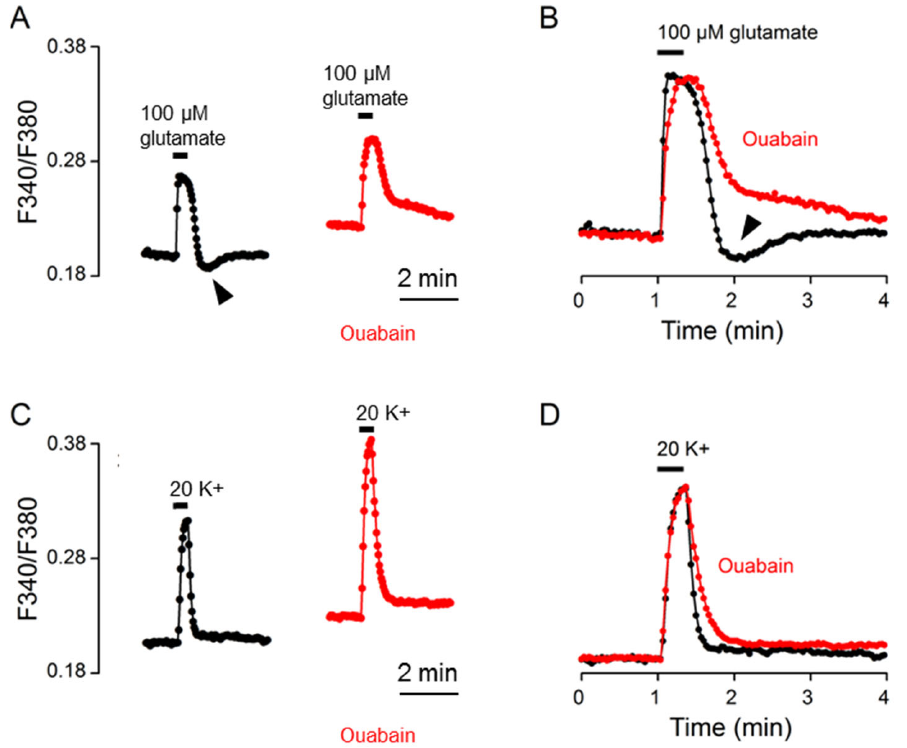
Figure 5. Ouabain effects on the Ca 2+ response to 100 µ M glutamate ( A , B ) and 20 mM K + ( C , D ) from the same cells. ( A , C ) A representative experiment (an average of 13 cells) showing the effects of 10 µ M ouabain on the Ca 2+ responses to 100 µ M glutamate ( A ) and 20 mM K + ( C ). ( B , D ) Superimposition of the Ca 2+ responses in control (black traces) and in 10 µ M ouabain (red traces) elicited by 100 µ M glutamate ( B ) and by 20 mM K + ( D ). Ouabain slowed the clearance of Ca 2+ for both glutamate- and 20 K + -evoked Ca 2+ response. Note that ouabain eliminated the rebound Ca 2+ suppression (marked by arrowheads) ( A , B ). Similar results were also obtained from 5 other